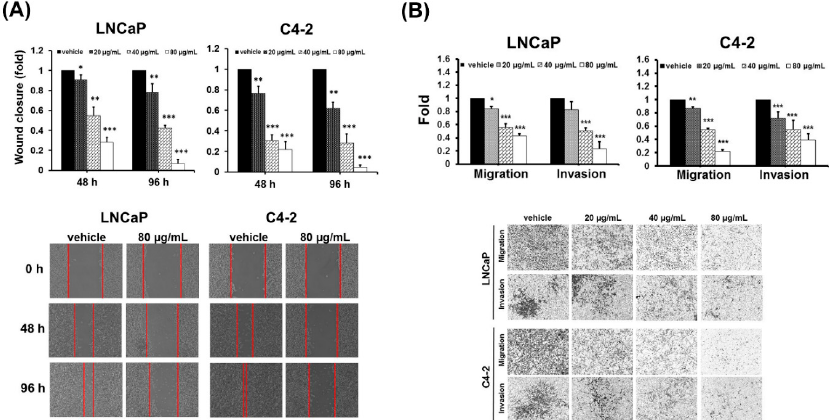
Figure 2. DFE reduces migration and invasion in PCa cells. ( A ) A wound healing assay. LNCaP and C4-2 cells were exposed to DFE (20, 40, and 80 µg/mL) or control vehicle. Wound closure was